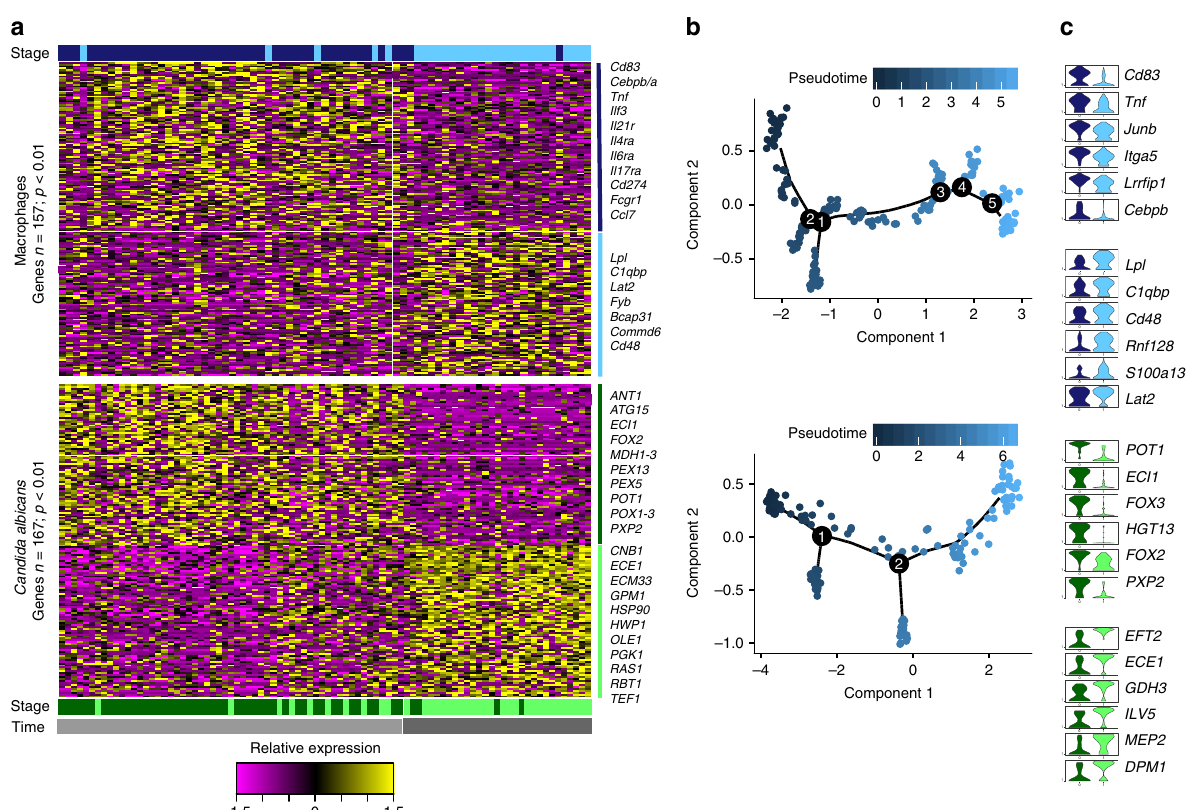
Fig. 4 Host – pathogen scRNA-Seq pro fi ling traced infection outcome. a Heat maps report parallel scaled expression [log TPM (transcripts per million) + 1 values] of differentially expressed genes for each co-state of macrophages infected with live C. albicans . Each column represents transcriptional signal from a single, infected macrophage and the C. albicans inside of it. (Top: macrophage response; bottom: C. albicans response). Color scheme of gene expression is based on z -score distribution from − 1.5 (purple) to 1.5 (yellow). Bottom and right margin color bars in each heat-map highlight co-state 1 (dark blue in macrophages (1 M ), and dark green in C. albicans (1 C )) and co-state 2 (blue in macrophages (2 M ), and green in C. albicans (2 C )), and time postinfection 2 h (gray) and 4 h (dark gray). b tSNE plot for macrophages (top) and C. albicans (bottom) colored by the pseudotime (dark blue to light blue). c Violin plots at right illustrate expression distribution of a subset six differentially expressed immune response or immune evasion genes for each co-state in macrophages (dark blue at stage 1; light blue at stage 2) and C. albicans (dark green at stage 1; light green at stage 2),